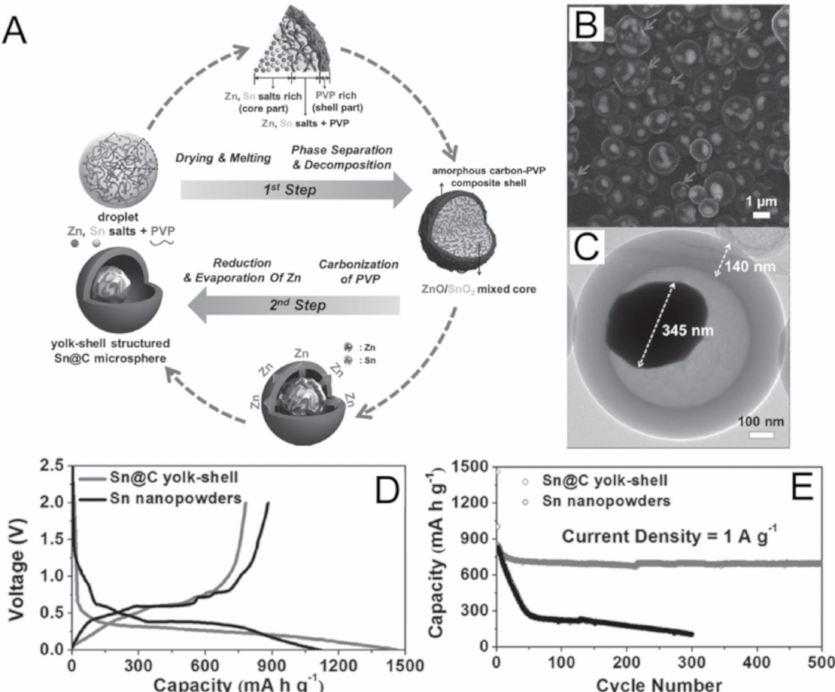
Figure 6. ( A ) Schematic illustration of the formation mechanism of yolk–shell Sn@C